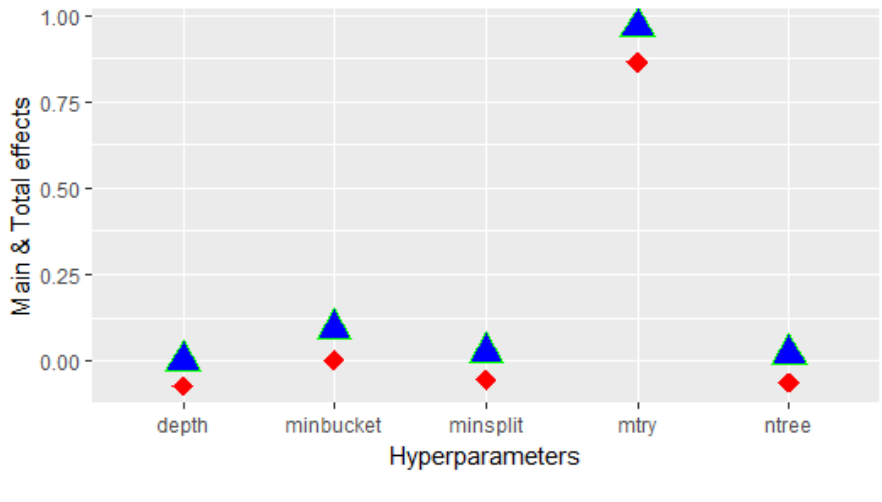
Figure 2. Hyper-parameter sensitivity analysis for the variable importance technique based on Conditional inference tree (CIT). Main effect (red): individual effect of each HP on the response. Total effects (blue): total effect of each HP when interacting with other HP on the